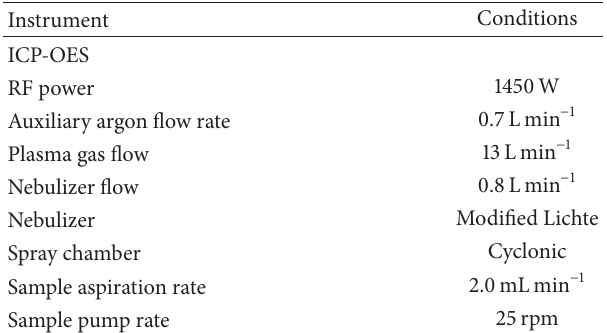
Figure 1: The map showing the sampling area. Table 1: Instrumental analytical conditions of element